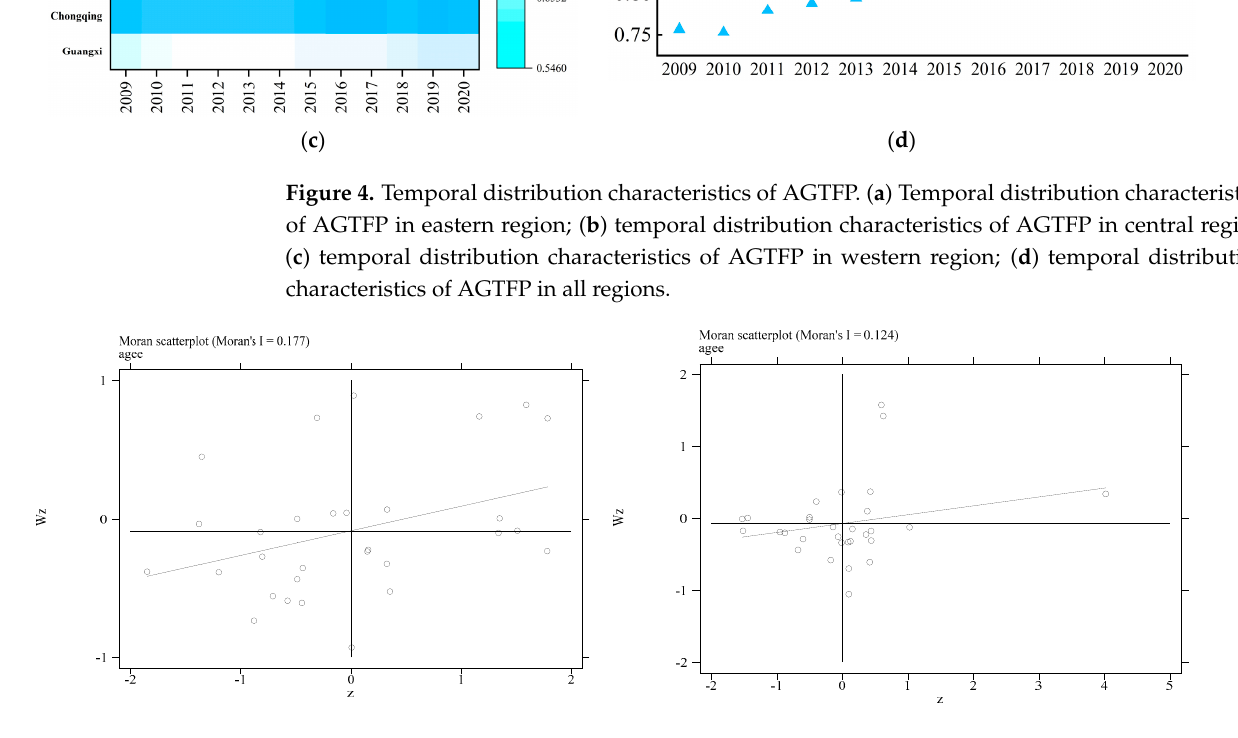
Table 6. The Global Moran’s I of AGTFP.